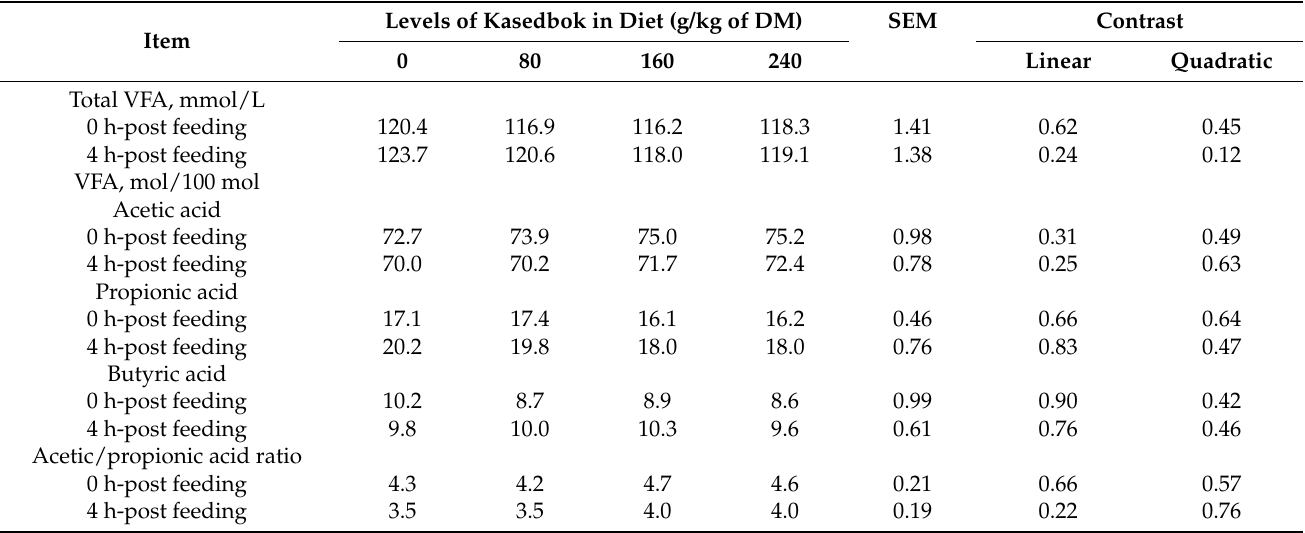
Table 4. Ruminal volatile fatty acid profile of Thai native beef